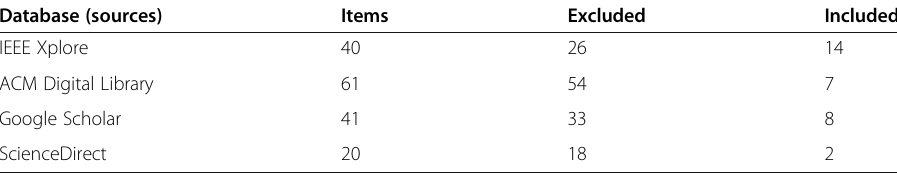
Table 4 Results of the literature search within the systematic review 2012 – 2018 Database (sources)